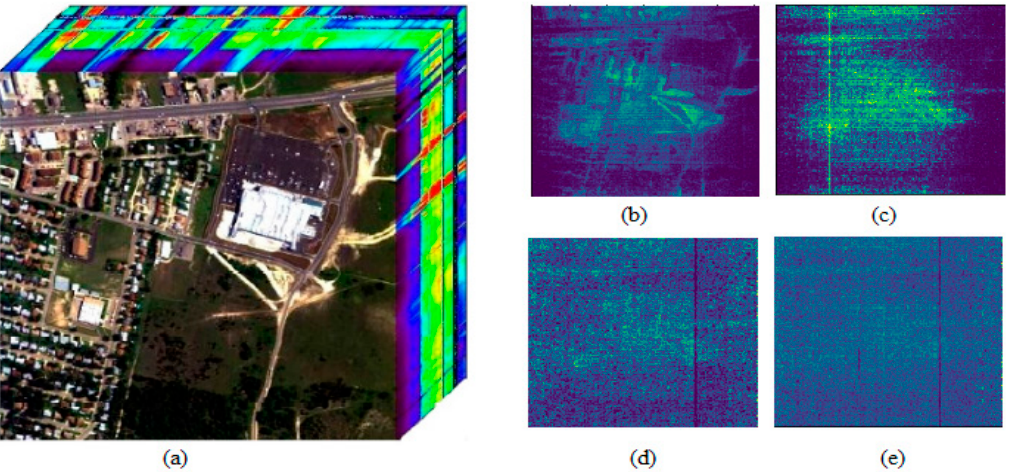
Figure 11. Hyperspectral dataset. ( a ) Urban. ( b ) Band 138. ( c ) Band 149. ( d ) Band 208. ( e ) Band 209.